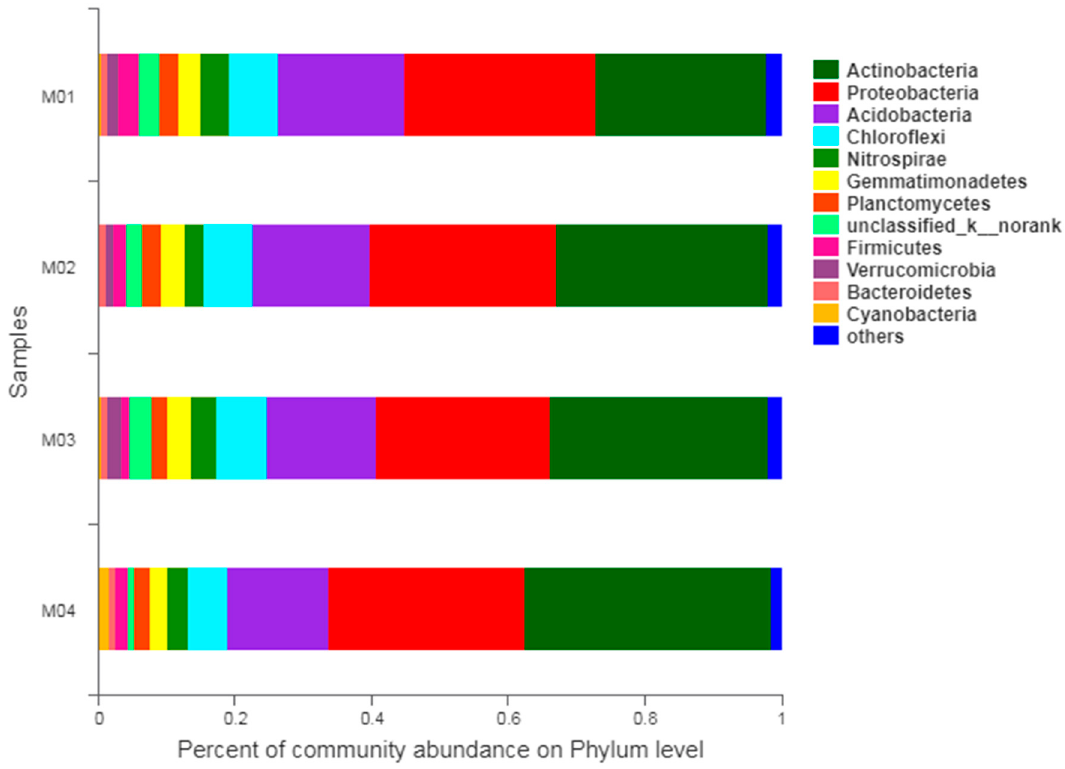
Figure 8. The phylum level of soil microorganism under different land uses.